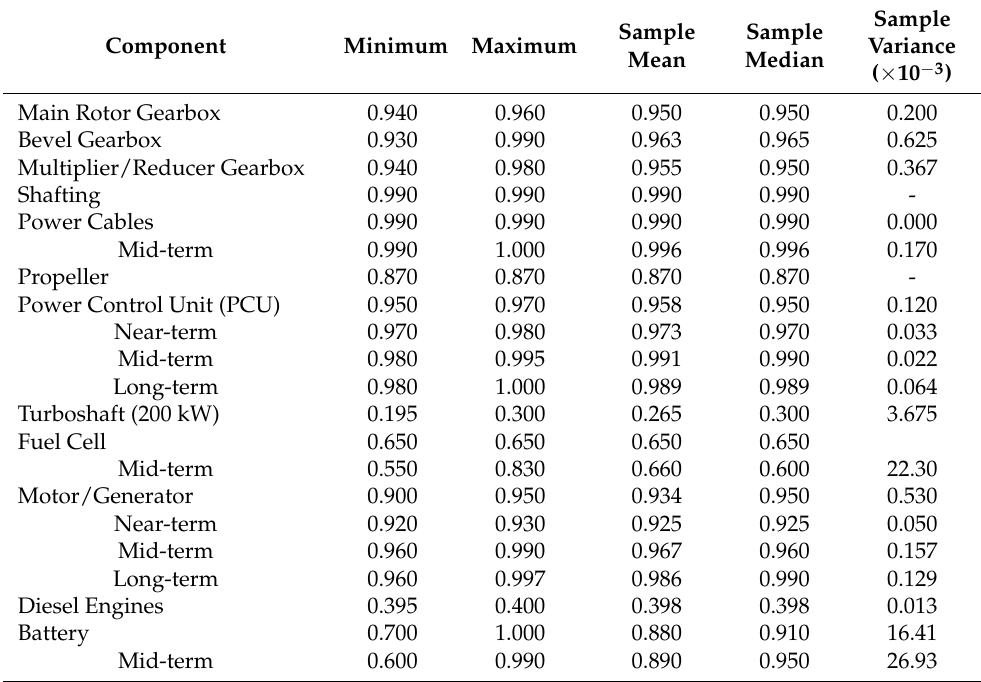
Table 2. Compiled values of state-of-the-art component efficiency, η X